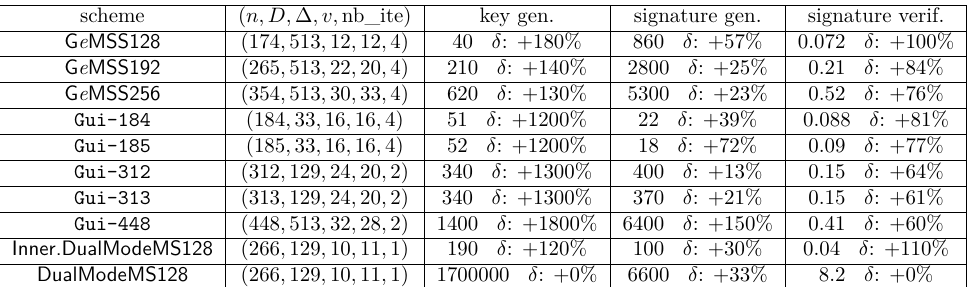
Table 18: Number of mega cycles (Mc) for each cryptographic operation with our li- brary for a Haswell processor (DesktopH), followed by the speed-up between the best implementation provided for the NIST submissions versus our implementation. For exam- ple, 40 δ : +180% means a performance of 40 Mc with MQsoft , and a performance of 40 × 2 . 8 = 110 Mc for the NIST implementations. key gen. signature